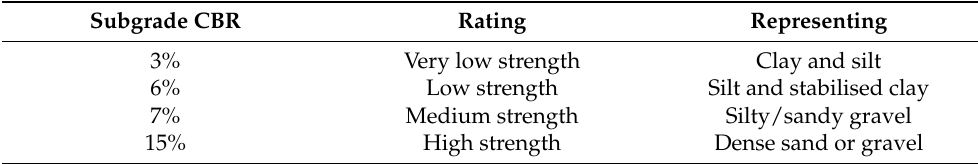
Table 2. Subgrade conditions.